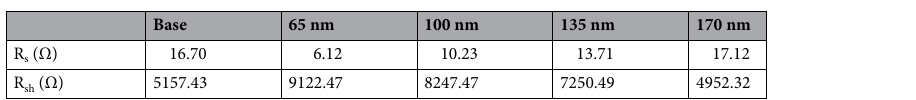
Table 2. Comparison of series and shunt resistances of perovskite solar cell with different PPL thickness.